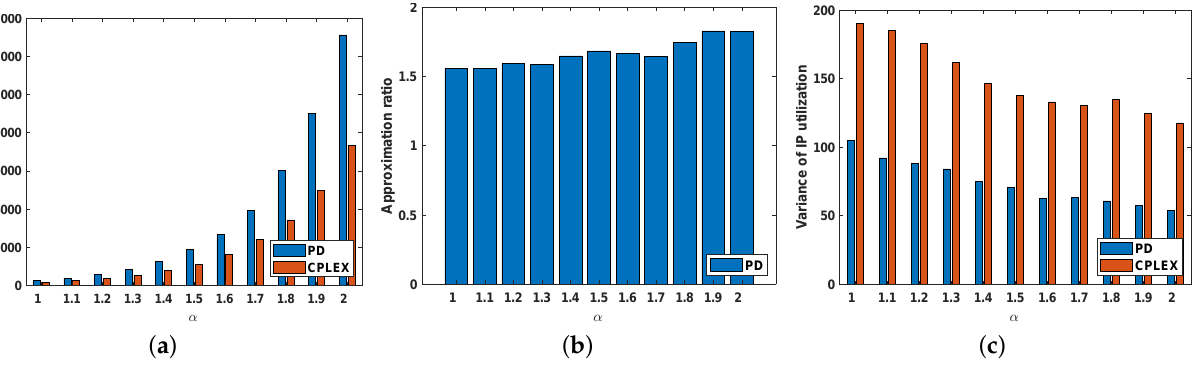
Figure 5. System performance with different values of α . ( a ) Total power. ( b ) Approximation ratio. ( c ) Variance in IP